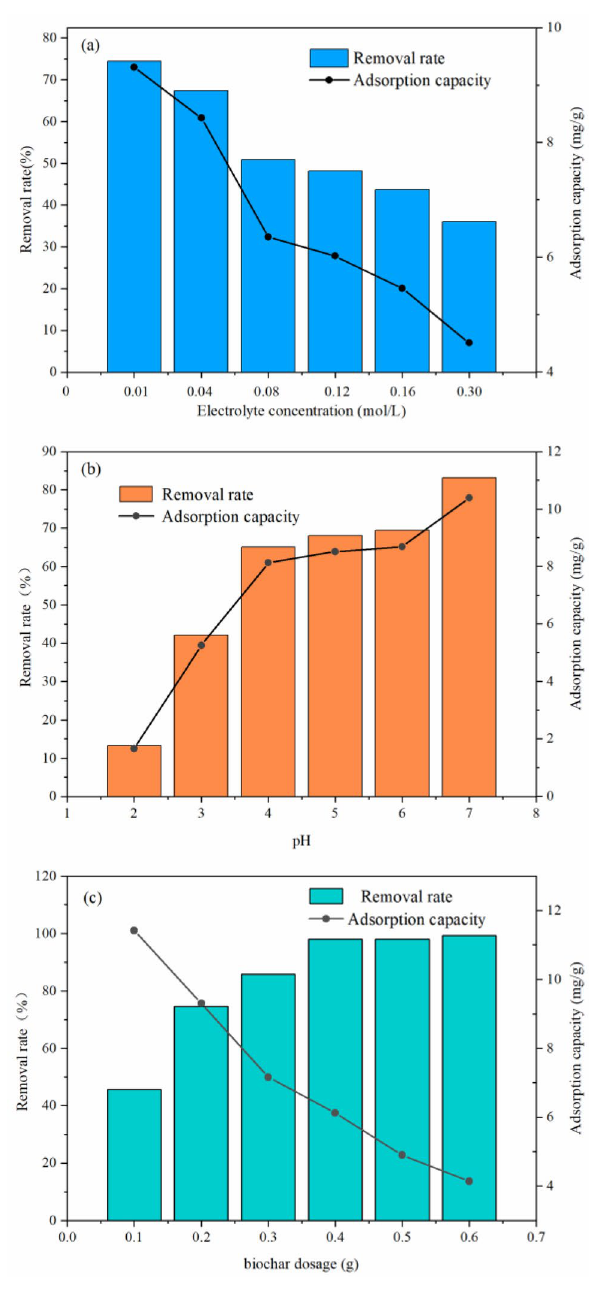
Figure 11. Effect of electrolyte concentration ( a ), pH value ( b ) and biochar dosage ( c ) on the Cd 2+ removal